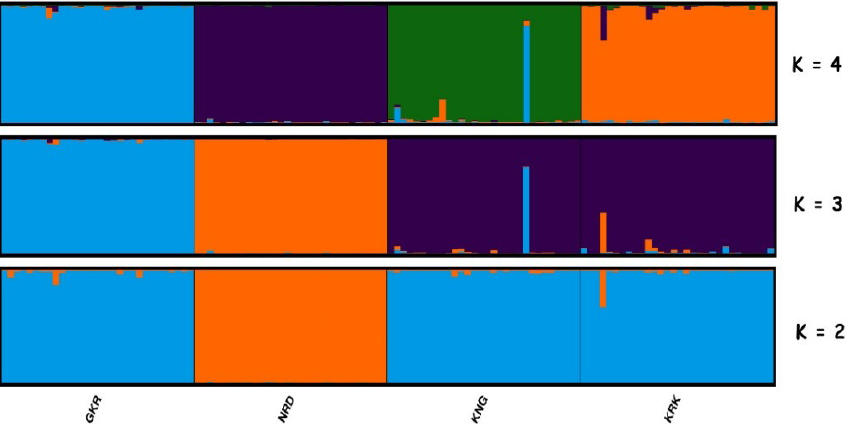
Figure 4. Structure cluster analysis of the studied individuals. The highest (cid:49)K value was obtained at K = 3. GKR: Güney Karaman; NRD: Norduz; KNG: Kangal; KRK: